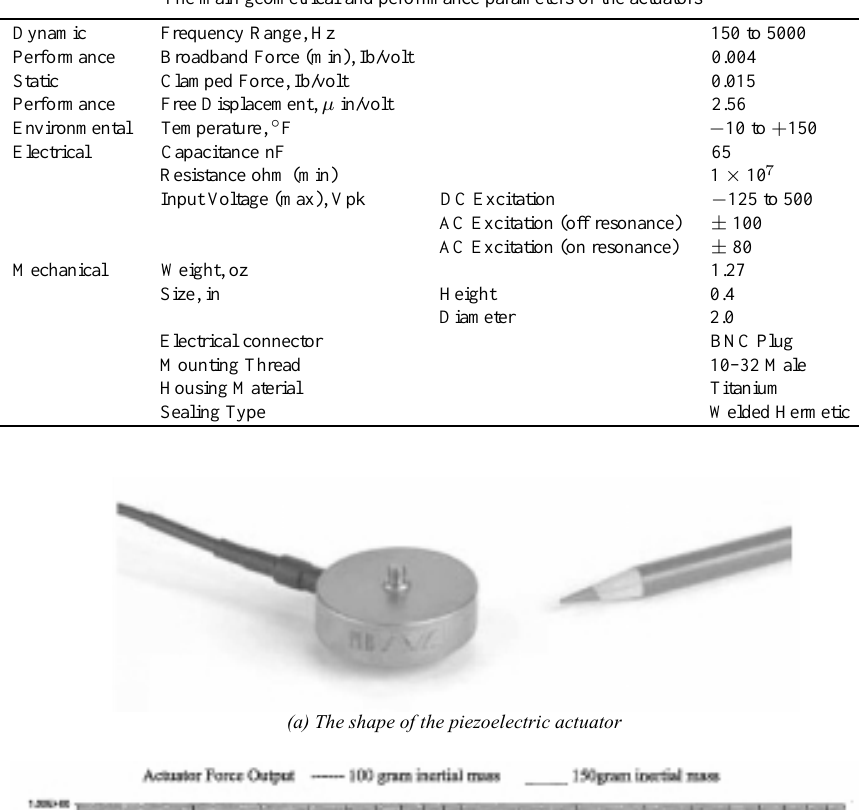
Table 1 The main geometrical and perofrmance parameters of the actuators